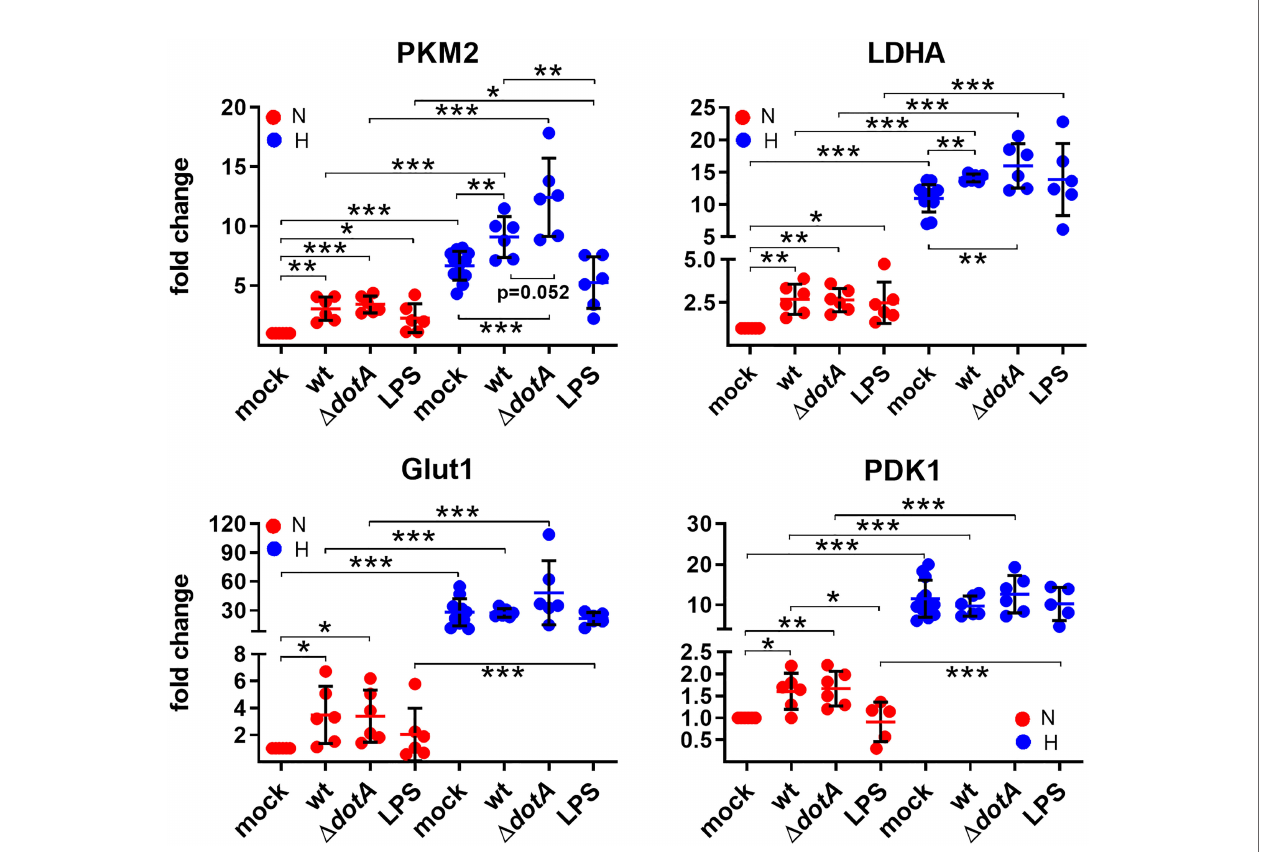
FIGURE 6 | C. burnetii -infected macrophages reveal a shift to glycolysis. BMDM were either uninfected (mock), infected with C. burnetii (wt), the T4SS transposon mutant ( D dotA ), or treated with LPS (100 ng/ml) for 24 h under normoxia (N) and hypoxia (H). Using qRT-PCR, the gene expression of murine PKM2 , LDHA , Glut1 , and PDK1 was analyzed. The data are shown as Mean ± SD of 2^- DD CT values (using murine HPRT as a calibrator). Fold changes are shown relative to uninfected cells under N. The data shown for each of the C. burnetii (wt and D dotA ) infection experiments and the LPS treatment experiment represent 3 independent experiments with biological duplicates. One sample t test or t test, n=5-6. ***p < 0.001, **p < 0.01, *p <